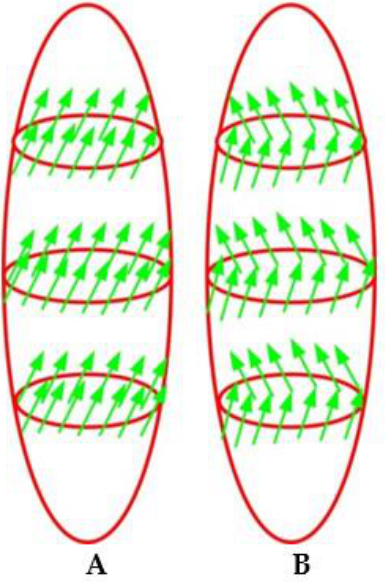
Figure 9. Models of the magnetization switching in a single-domain elongated spheroid: ( A ) co- herent rotation of magnetic moments; ( B ) rotation of magnetic moments of the “curling” type